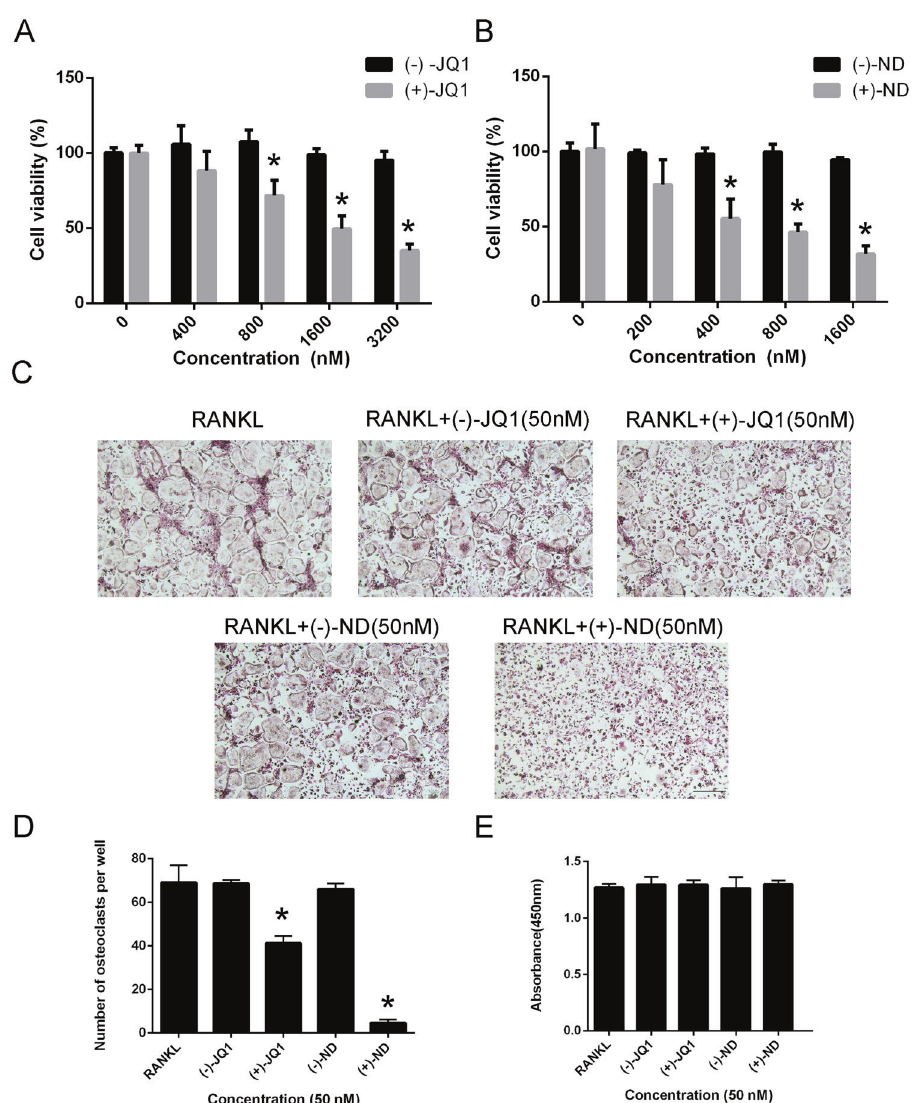
Fig. 2 Compounds suppresses RANKL-induced osteoclast formation with no cytotoxicity in vitro. Effects of ( + )-JQ1, (-)-JQ1 ( A ), ( + )-ND, (-)-ND ( B ) on viability of BMMs at 72 h ( n = 3). C BMMs were stimulated with RANKL in the presence of ( + )-JQ1, (-)-JQ1, ( + )-ND, or (-)-ND (50 nM) and stained for TRAP detection. D Quanti fi cation analysis of TRAP-positive multinucleated (nuclei ≥ 3) cells. E Cytotoxic effects of ( + )-JQ1, (-)-JQ1, ( + )-ND, or (-)-ND (50 nM) on BMMs were evaluated by CCK-8 analysis at 96 h. Error bars are indicated as mean ± SD. * P < 0.05 compared with displayed trivial effect in the late stages of the process (Fig. 3C and D). Collectively, these data showed that ( + )-ND represses osteoclast formation without cytotoxic effects.